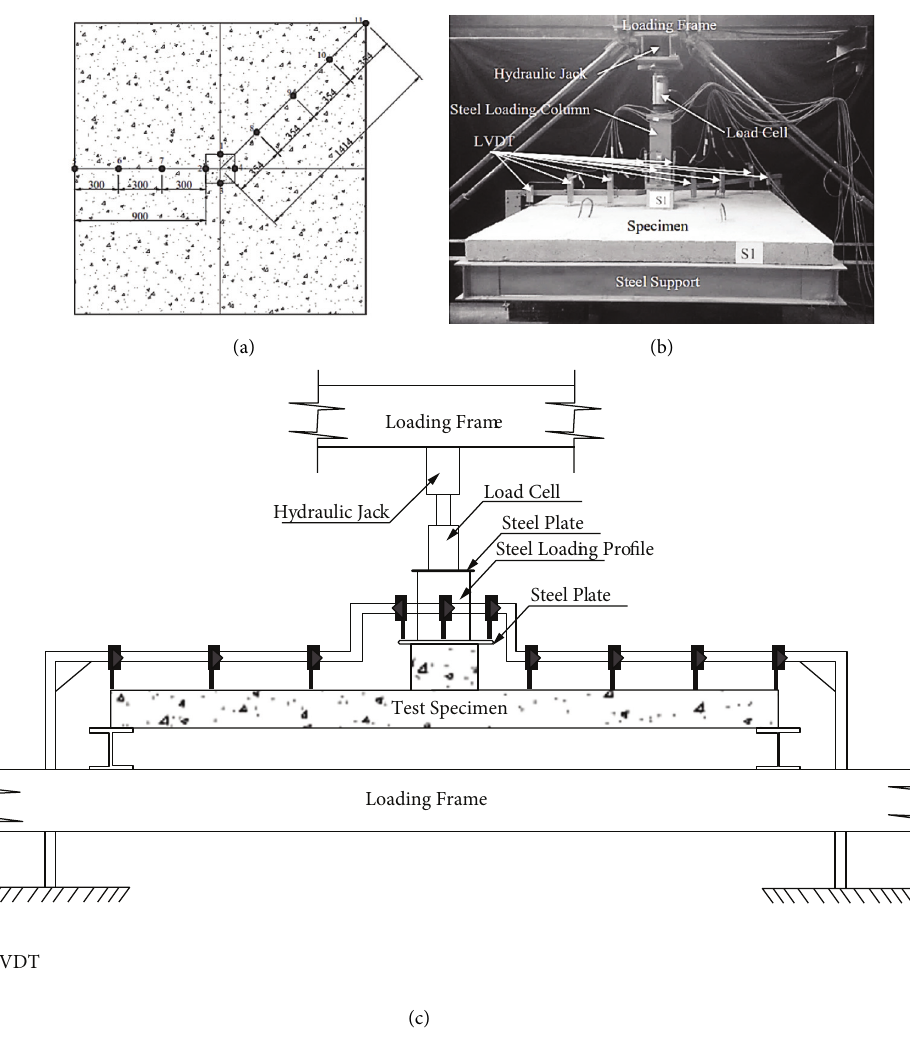
Figure 2: Reinforced concrete slab test layout [33]. (a) Location of strain gauges. (b) Schematic figure of the experiment. (c) The manner in which the experiment is conducted.